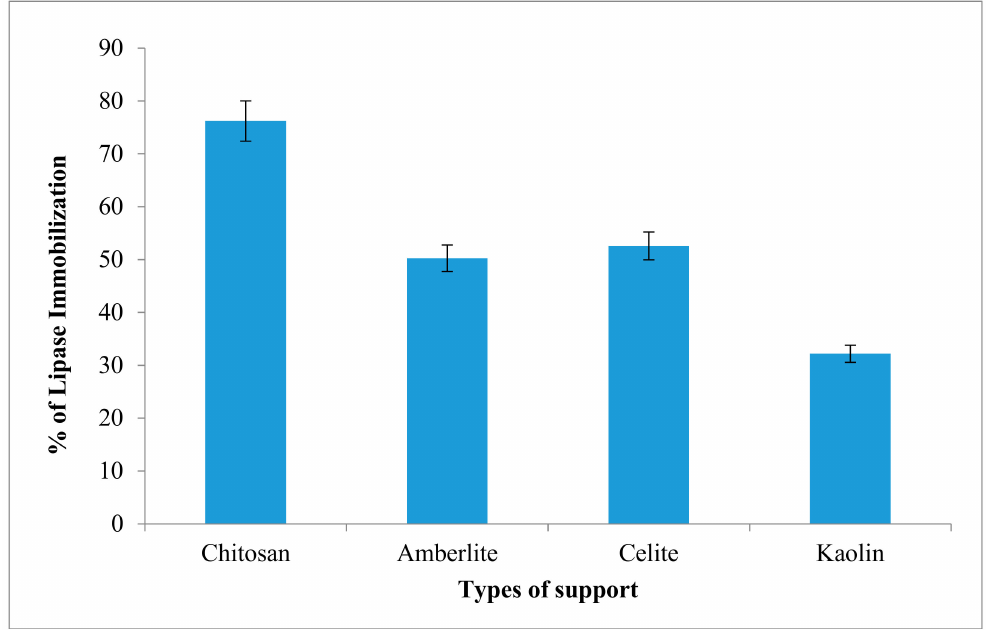
Figure 6. Percentage of AMS8 lipase immobilization on various matrices. Protein content was determined using Bradford (1976) method and percentage of immobilization was calculated using formula described in earlier